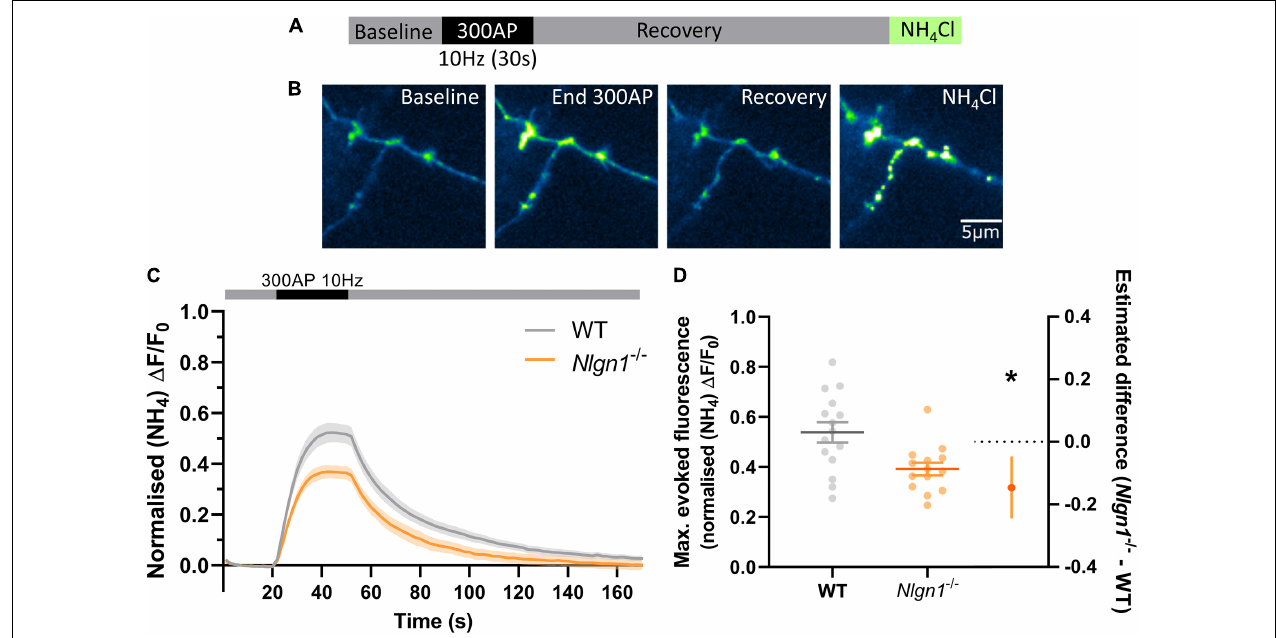
FIGURE 2 | Nlgn1 − / − synapses display a change in the balance of exocytosis and endocytosis. Nlgn1 − / − and WT neurons transfected with sypHy were stimulated with 300 action potentials at 10 Hz, and change in fluorescence monitored over time. Neurons were then perfused with NH 4 Cl to reveal total sypHy fluorescence. (A) Overview of experimental paradigm. (B) Representative images of relative sypHy fluorescence at baseline, following 300 action potentials (end 300 AP), 120 s after cessation of stimulus train (recovery), and following perfusion with NH 4 Cl. Scale bar indicates 5 µ m. Images are false coloured to show relative sypHy fluorescence, with warmer colours indicating increased fluorescence intensity. (C) Time trace of mean ( ± SEM) changes in sypHy fluorescence, normalised to total fluorescence. (D) Peak sypHy fluorescence during stimulus train, normalised to total fluorescence. Scatter plots show individual n , bars indicate mean ± SEM. Forest plot shows estimated difference between group means with 95% CI, unpaired t -test, * p < 0.05 ( p = 0.0055). N = 14–15 individual fields of view from independent coverslips.